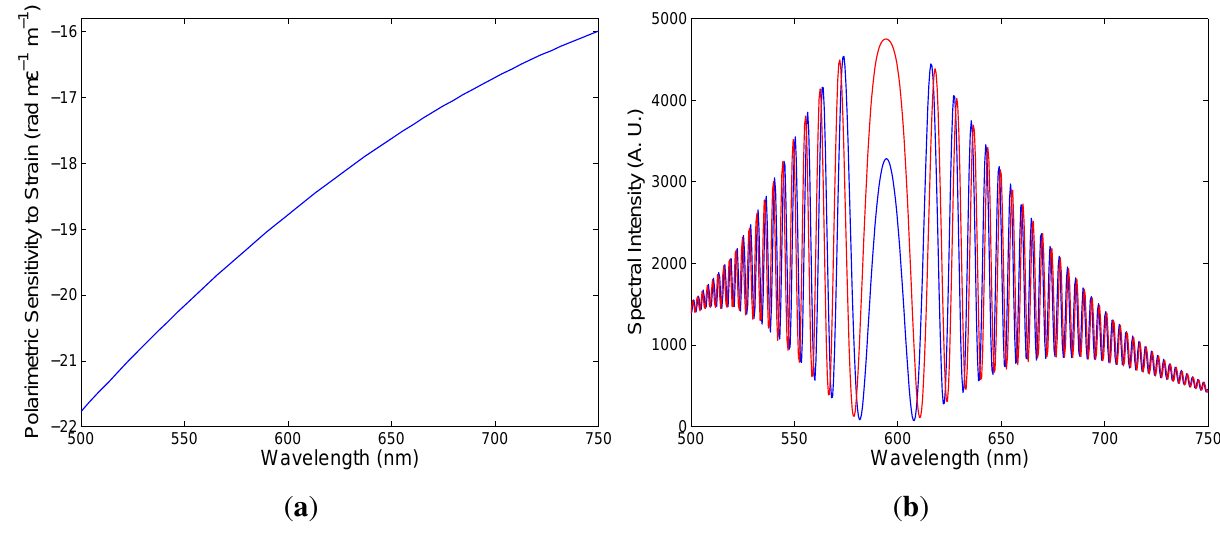
Figure 7. The spectral dependence of the polarimetric sensitivity to strain: a negative sign ( a ). Two theoretical spectra corresponding to the fiber elongations, ∆ L = 100 (cid:22) m (blue) and ∆ L = 150 (cid:22) m (red) ( b